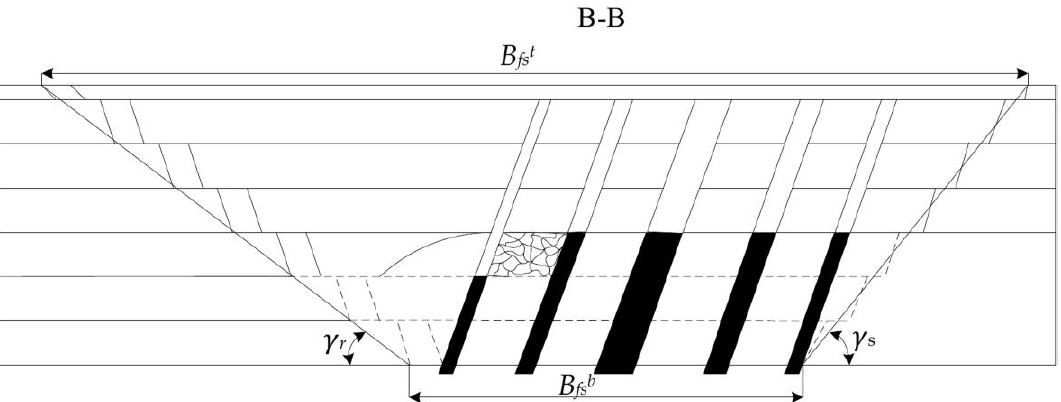
Figure 4. Cross section of the surface mine field.